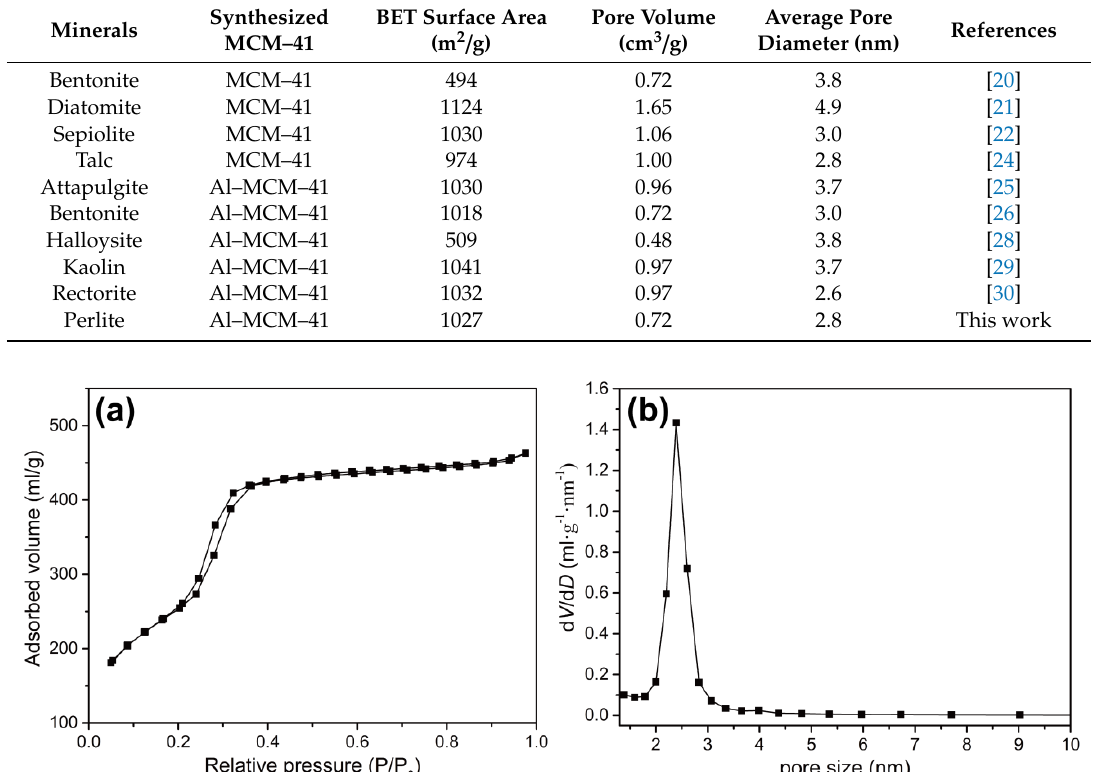
Figure 4. ( a ) N 2 adsorption–desorption isotherms of Al–MCM–41; ( b ) Barett–Joyner–Halenda (BJH) pore size distribution curves of Al–MCM–41.